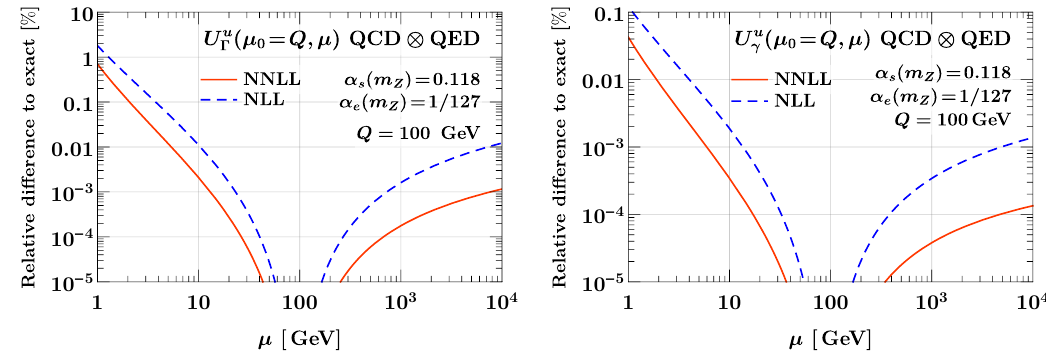
Figure 10 . Deviation of the seminumerical kernels from the exact result for the joint QCD (cid:10) QED u -quark evolution kernel at NLL (dashed) and NNLL (solid). The cusp contribution is shown on the left and the noncusp contribution on the